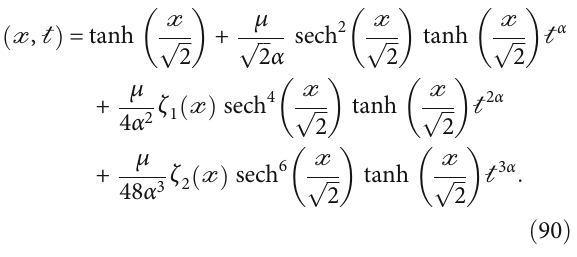
− u u − u 2 q HAM j and (b) j 2 NIM j .